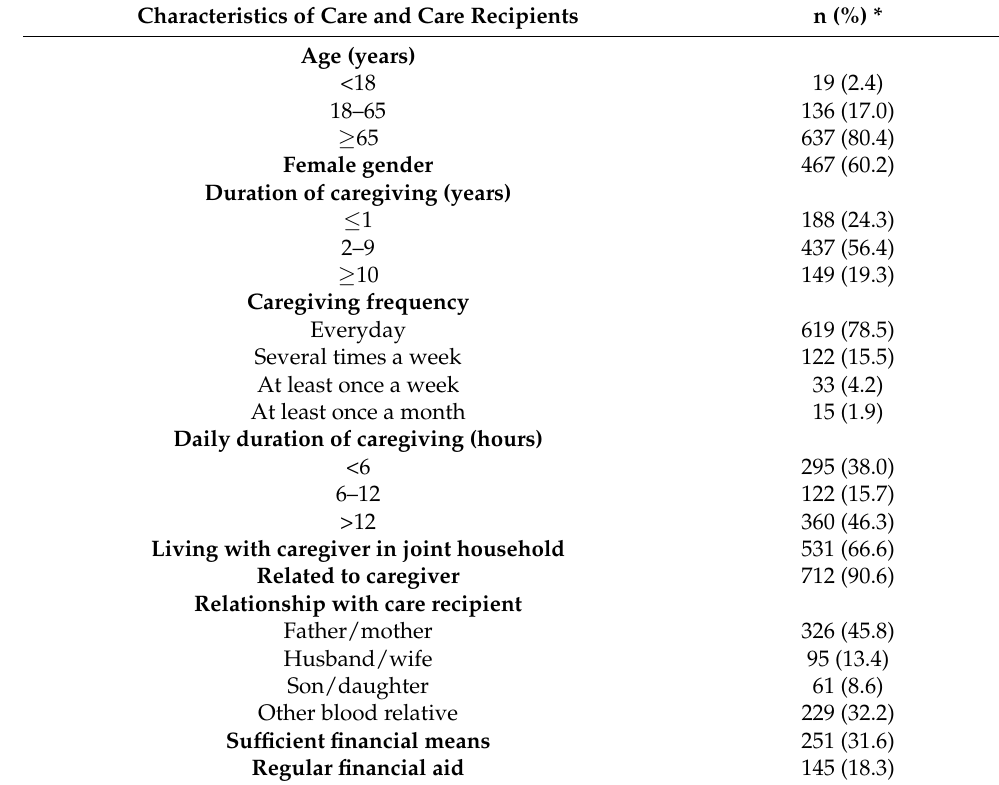
Table 2. Characteristics of care and care recipients.